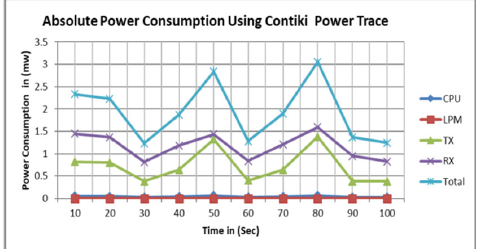
Figure 12. The total absolute power consumption for one testbed node measured over time.